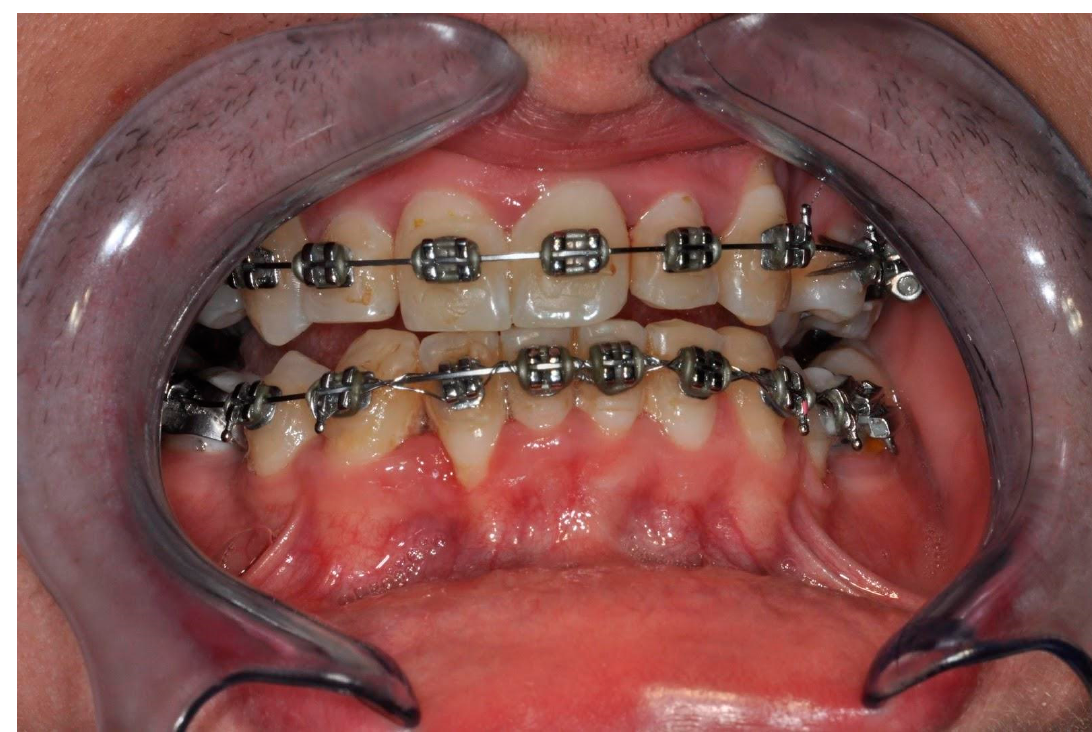
Figure 1. Clinical picture before treatment showing the inadequate amount of keratinized gingiva, Miller grade II gingival recession in the area of tooth 42, a thin biotype of the gingiva with the correct vestibule height as well as including calculus, gingival recessions, and alveolar concaves and concavities.